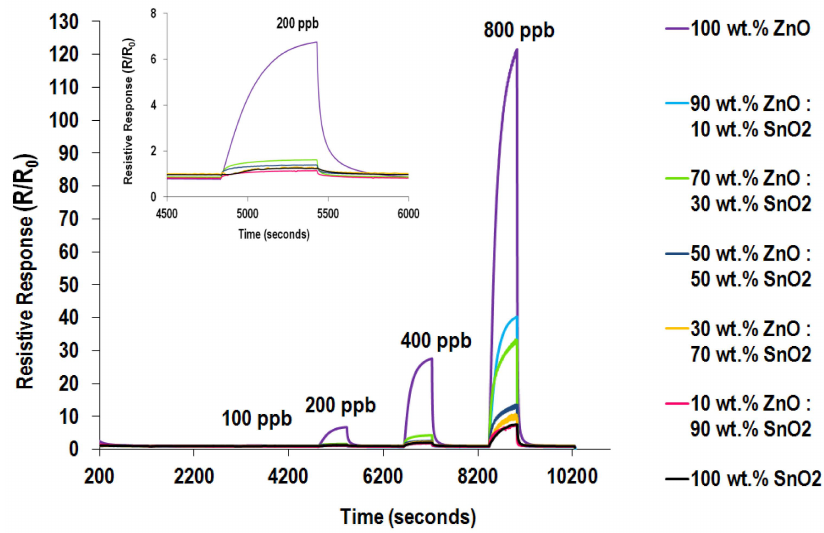
Figure 7. Resistive response traces of SnO 2 -ZnO array towards 100, 200, 400 and 800 ppb NO 2 gas, at an operating temperature of 300 ˝ C. The inset projects the resistive responses of the array towards 200 ppb NO 2 . The best response of 120 is observed for the 100 wt% ZnO device.